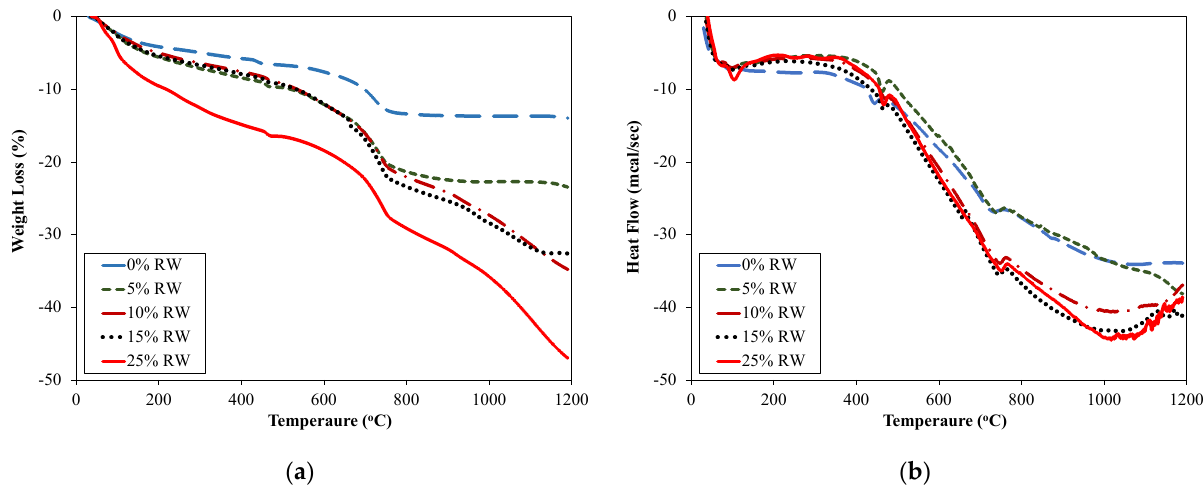
Figure 9. Thermal analysis results for specimens incorporating RW. ( a ) Weight loss; ( b ) Heat flow. For example, approximately 5.50%, 7.65%, and 15.02% losses in mass were observed for specimens incorporating 0%, 10%, and 25% of RW, respectively, in the temperature range of 0 to 400 ◦ C. Similarly, mass losses of 4.50%, 7.95%, and 8.01% were observed for 0%, 10%, and 25% of RW specimens, respectively, in the temperature range of 401 to 700 ◦ C. At 1200 ◦ C, the total mass losses of specimens incorporating 0%, 5%, 10%, 15%, and 25% of RW were around 14%, 23%, 32%, 35%, and 47%, respectively. This mass loss was related